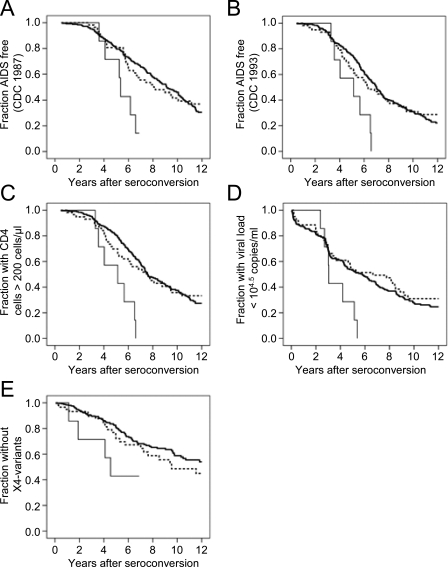
Survival Analysis for the H43Y GenotypeKaplan Meier analysis for time in years from seroconversion to AIDS according to the CDC 1987 definition (A), to AIDS according to the CDC 1993 definition (B), to CD4 count below 200 cells/μl blood (C), to viral RNA load above 104.5 copies per ml plasma (D), and to first detection of X4-variants (E) based on the H43Y genotype. Bold lines indicate individuals with the wild type genotype (43HH); dashed black lines indicate individuals heterozygous for the 43Y genotype (43HY); thin black lines indicate individuals homozygous for the 43Y genotype (43YY).